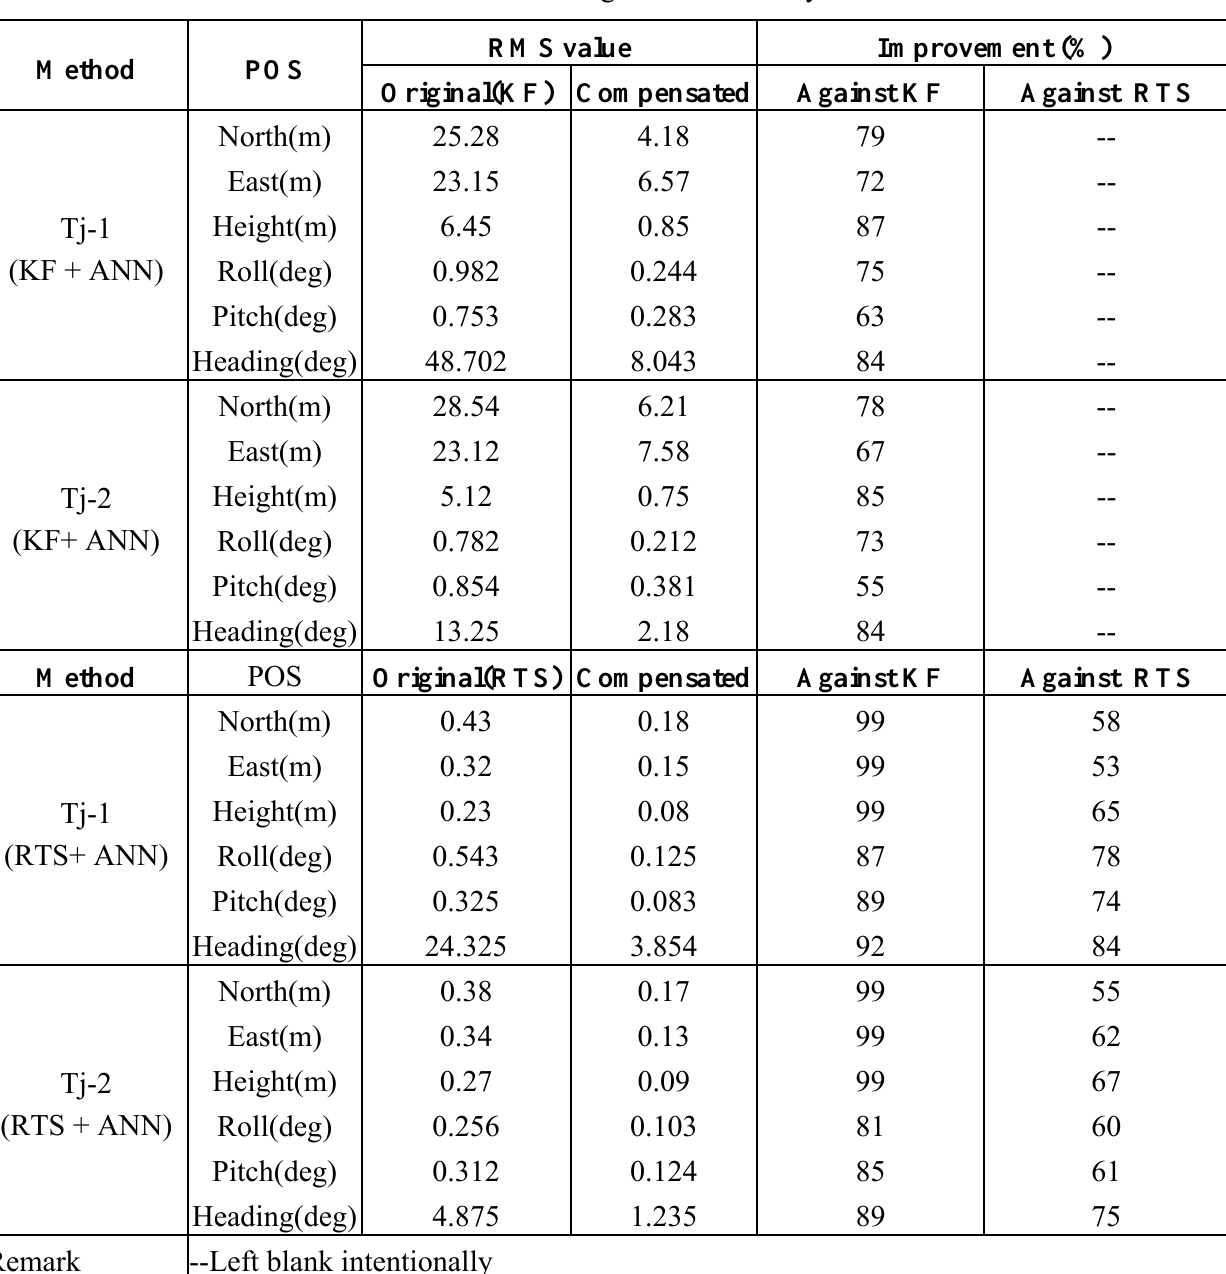
Table 3. Testing results